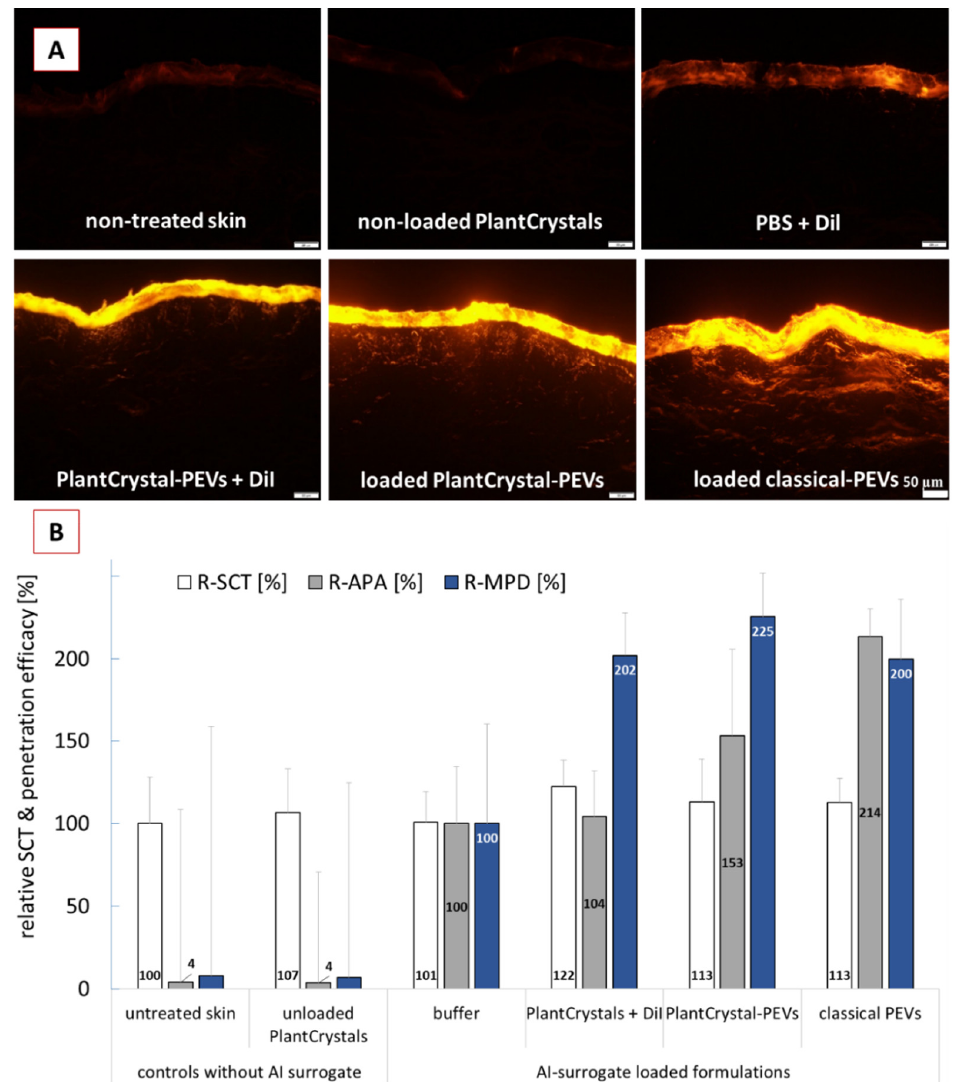
Figure 6. Dermal penetration efficacy of DiI used as AI surrogate in the different formulations. ( A ): images from skin sections obtained by inverted epifluorescence microscopy (all images taken with identical settings: 200-fold magnification, 50 ms exposure time, 100% attenuator of light source set to 100%, scale bar = 50 µm), ( B ): penetration parameters obtained with digital image analysis (R-SCT = relative stratum corneum thickness, R-APA = relative amount of penetrated AI-surrogate, R-MPD = relative mean penetration depth of AI surrogate).